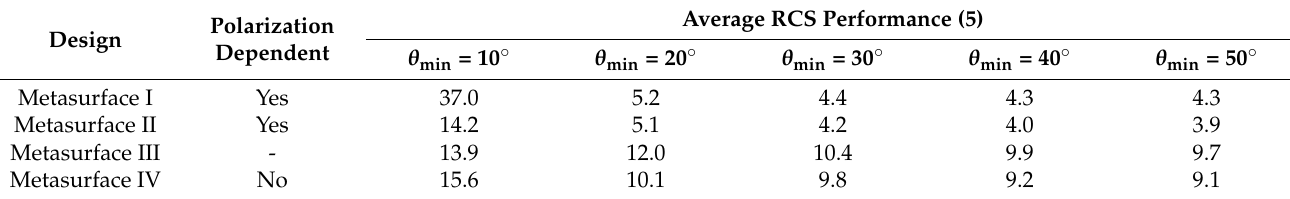
Figure 8. Configuration of the metasurfaces; ( a ) metasurface I [25], ( b ) metasurface II [28], ( c ) meta- surface III [29], and ( d ) metasurface IV. Table 1. Performance Comparison of Different Metasurface